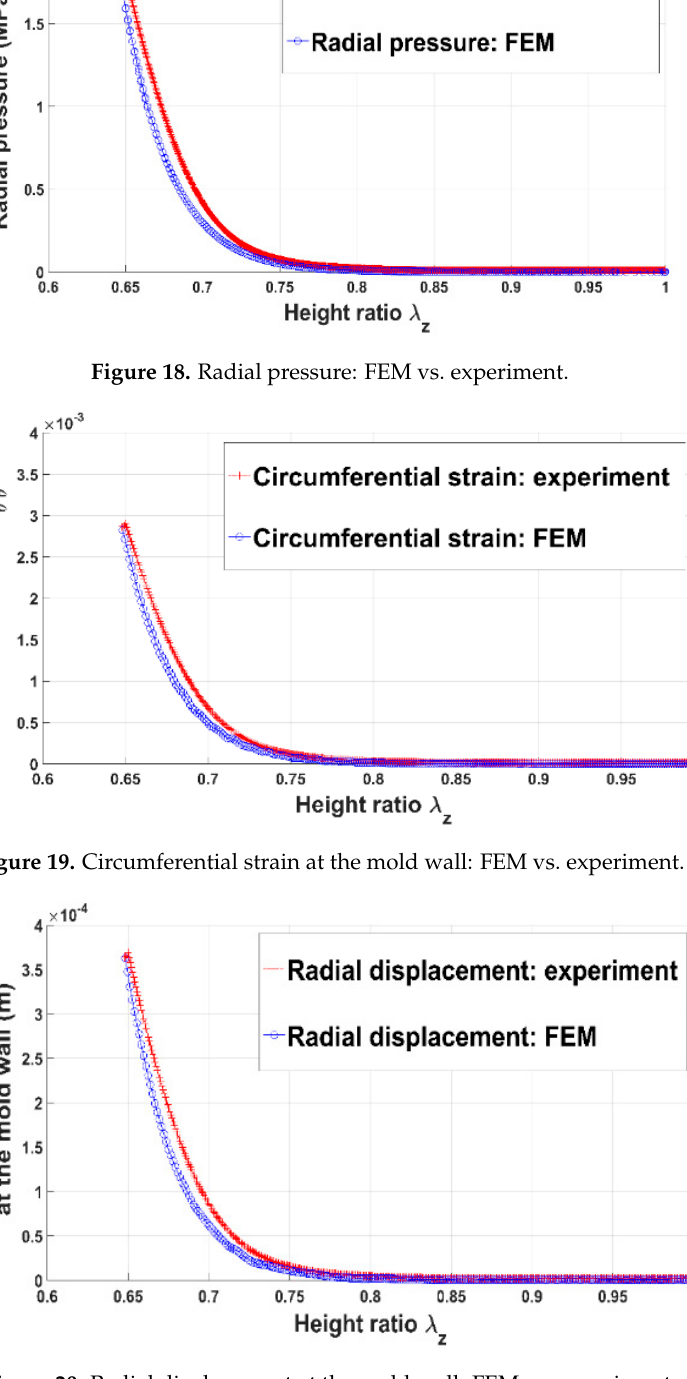
Figure 20. Radial displacement at the mold wall: FEM vs. experiment.